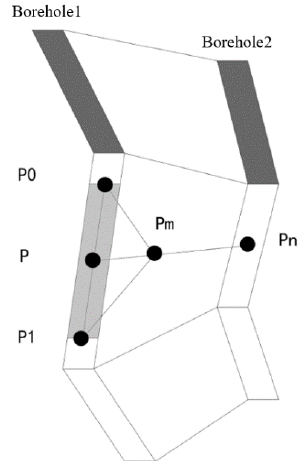
Figure 9. Calculating and determining the position of the pinch-out control point.